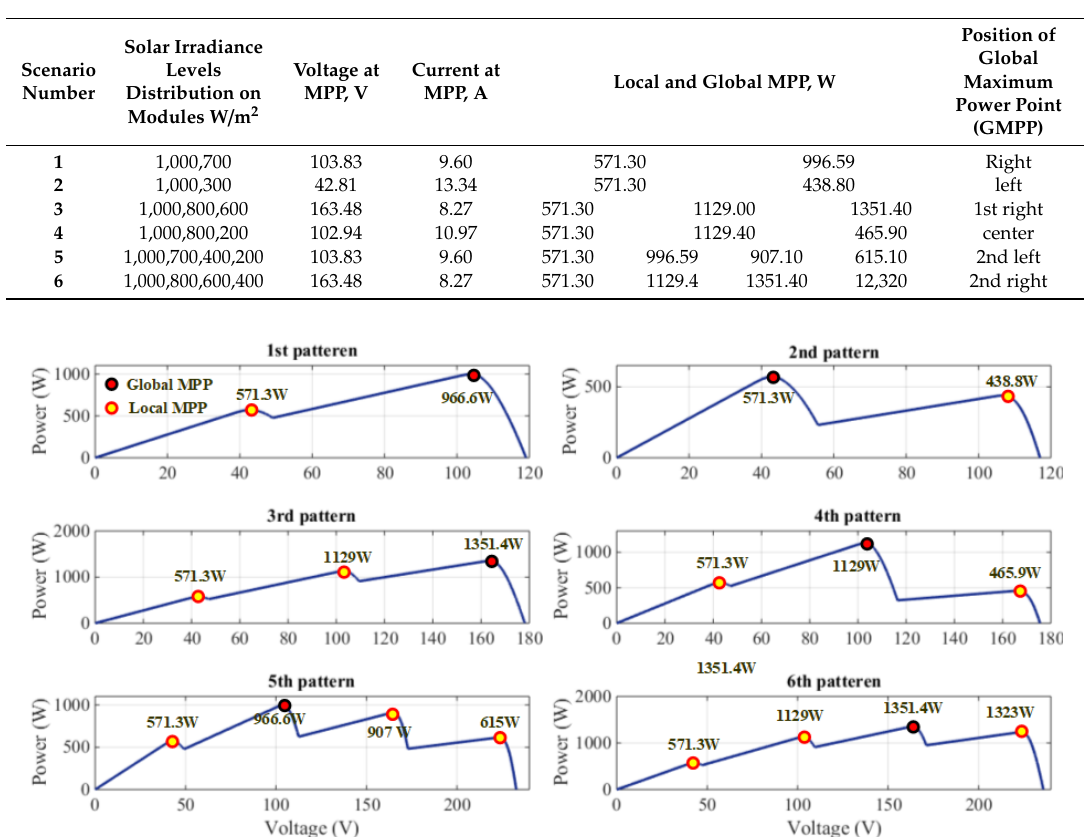
Table 2. The detailed description of different considered shading scenarios. MPP: maximum power point.